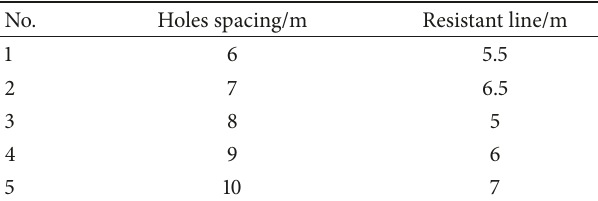
Table 2: Evenly designed U 5 (5 2 ) experiment